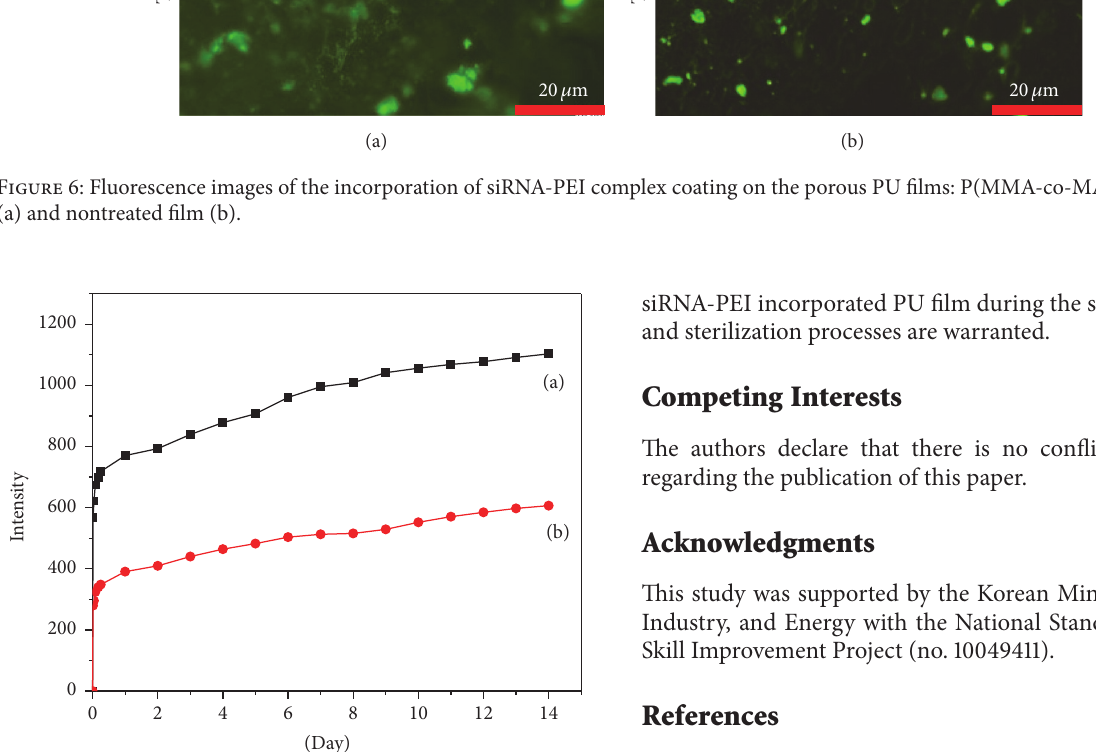
Figure7:Cumulativefluorescenceintensitiesfromthemicroporous films: P(MMA-co-MAA)-treated PU film (a) and nontreated PU film